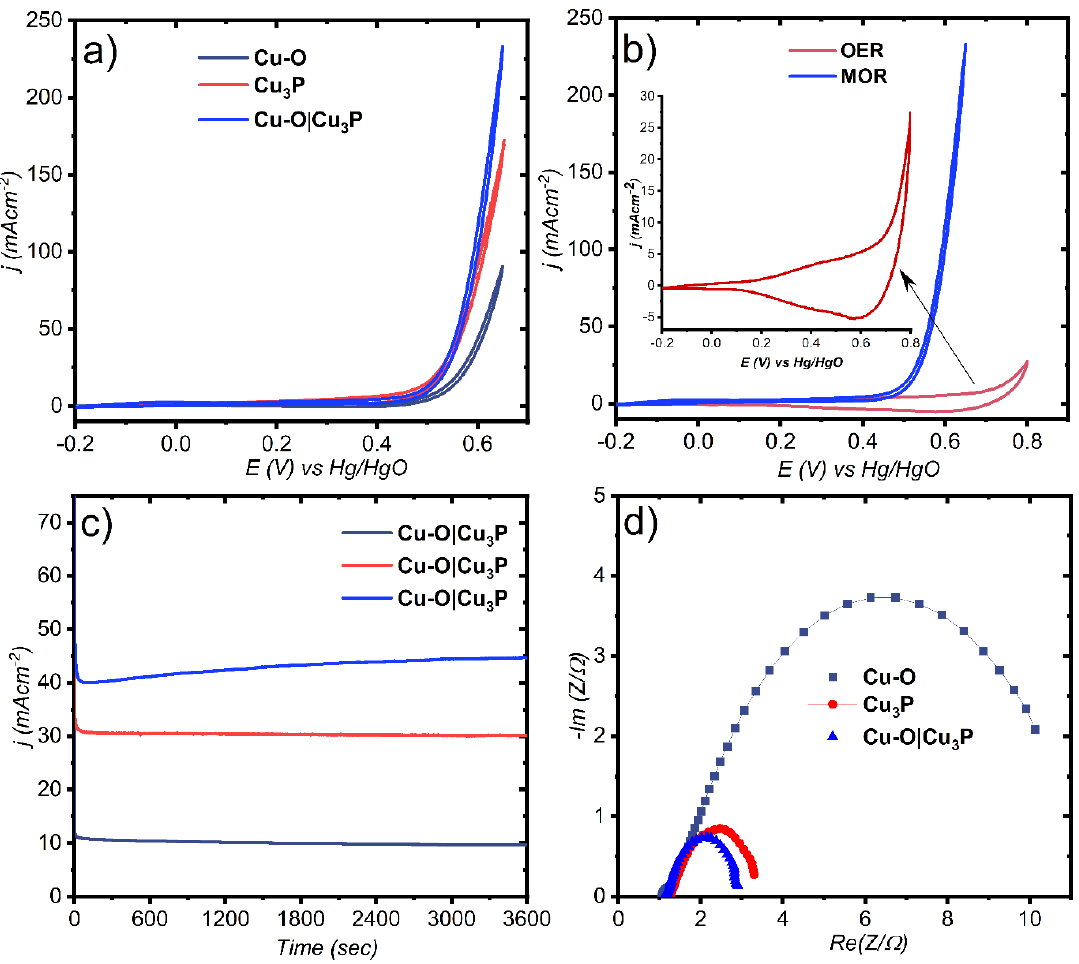
Figure 5. ( a ) Cyclic voltammetry showing MOR of three catalysts carried out in 1M methanol and 1M KOH; ( b ) comparative OER and MOR results of Cu-O|Cu 3 P (the inset presents OER result); ( c ) comparison of CA results carried out at fixed faradic potentials; and ( d ) Nyquist impedance plots of Cu-O, Cu 3 P, and Cu-O|Cu 3